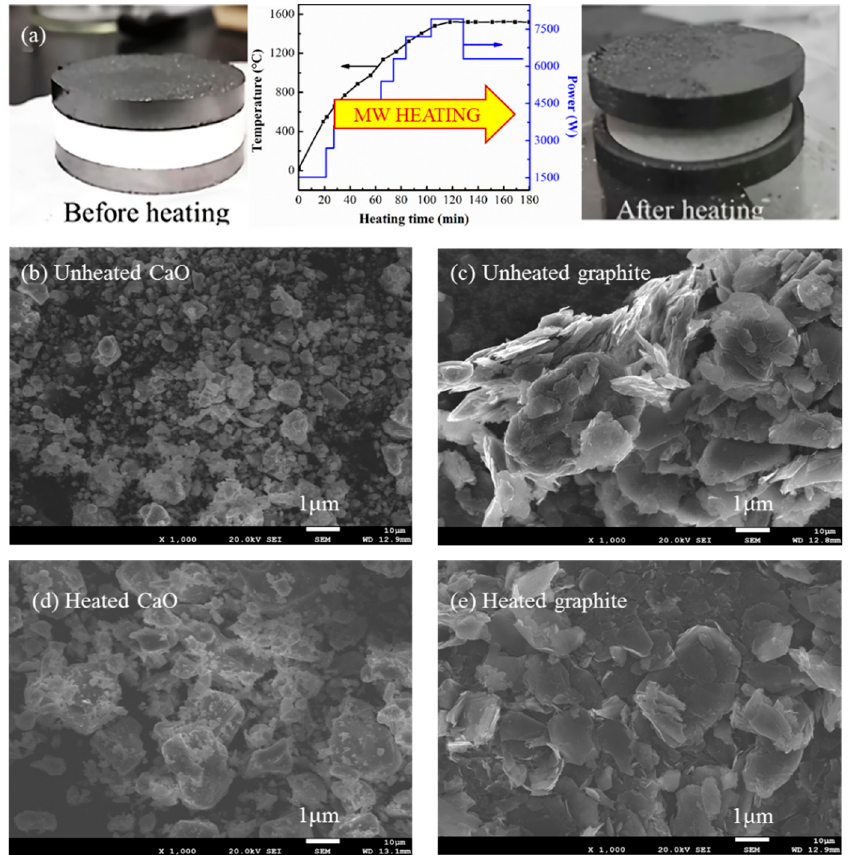
Figure 3. The appearance of CaO and graphite tables before and after MW heating ( a ) and the SEM images of CaO ( b , d ) and graphite ( c,e ); before ( b , c ) and after ( d , e ) MW heating at 1520 °C.